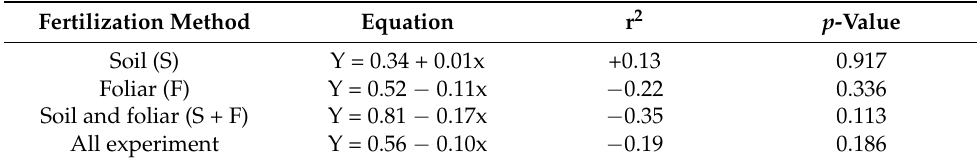
Table 5. Linear regression for selenium content in grain (y) and yield (x).